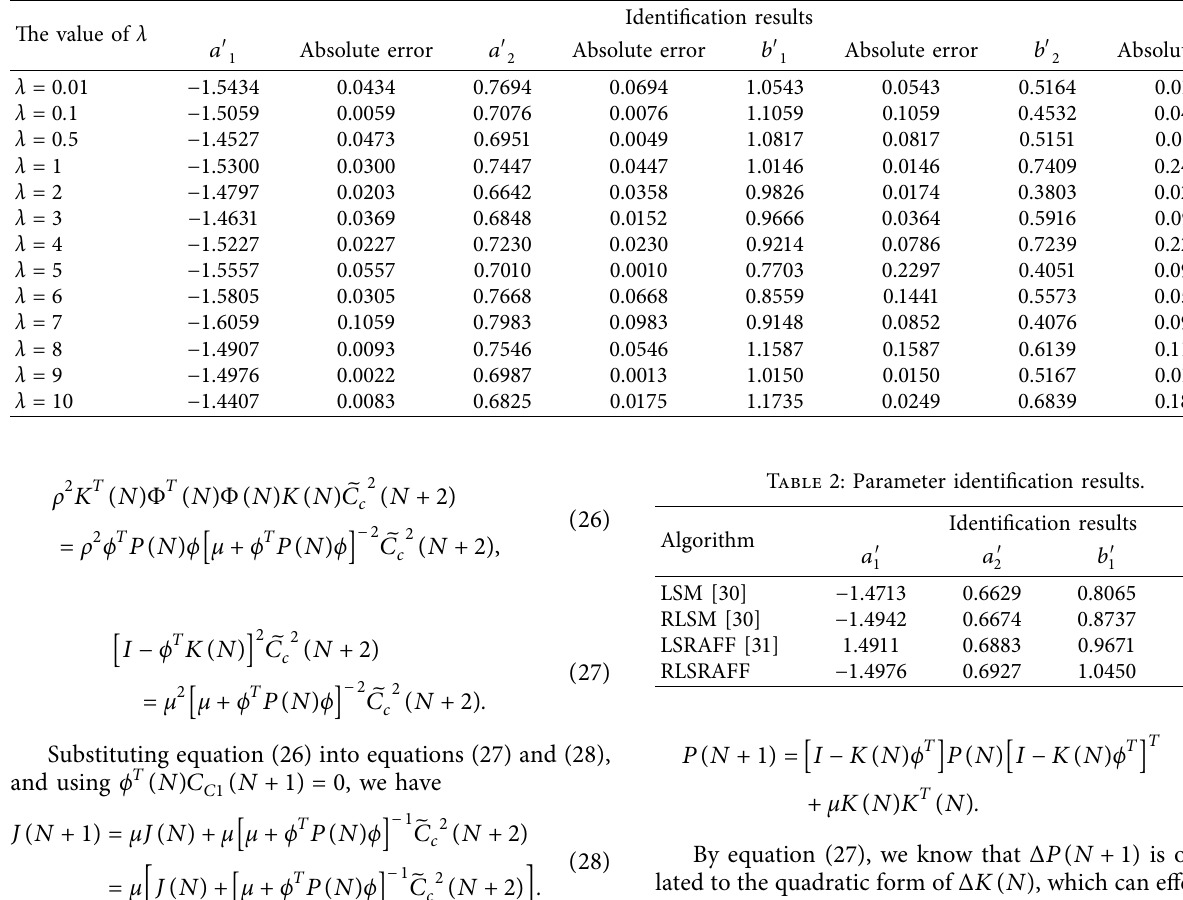
Table 1: The parameter identification results of different λ